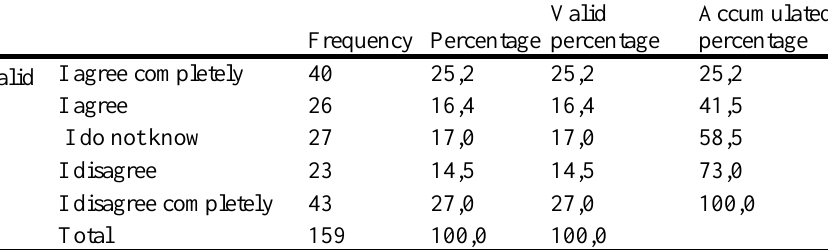
Valid percentage questionnaires´ results, question 15 “Students feel weak when they are unable to understand contents which are explained in the second language”.